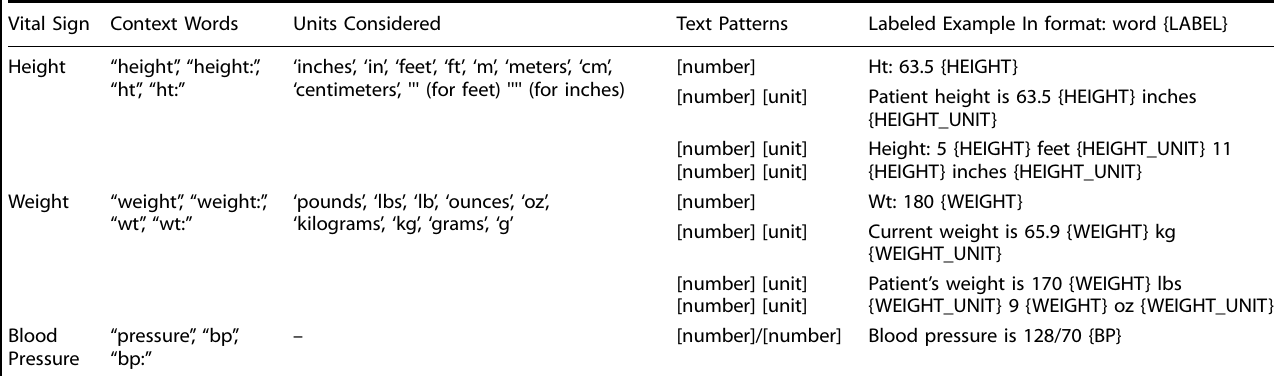
Table 3. Regular expression rule-based approach for vital sign labeling. Units Considered Text Patterns Labeled Example In format: word